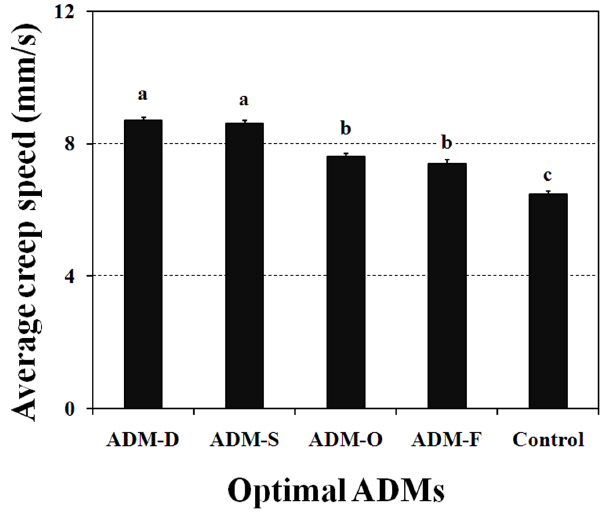
Figure 4. Locomotory performance of O.sauteri fed with either different optimal ADMs or T.cinnabarinus . The columns and bars represent mean + SE. The different letters at the top of the columns indicate significant differences based on the LSD test (P , 0.05).